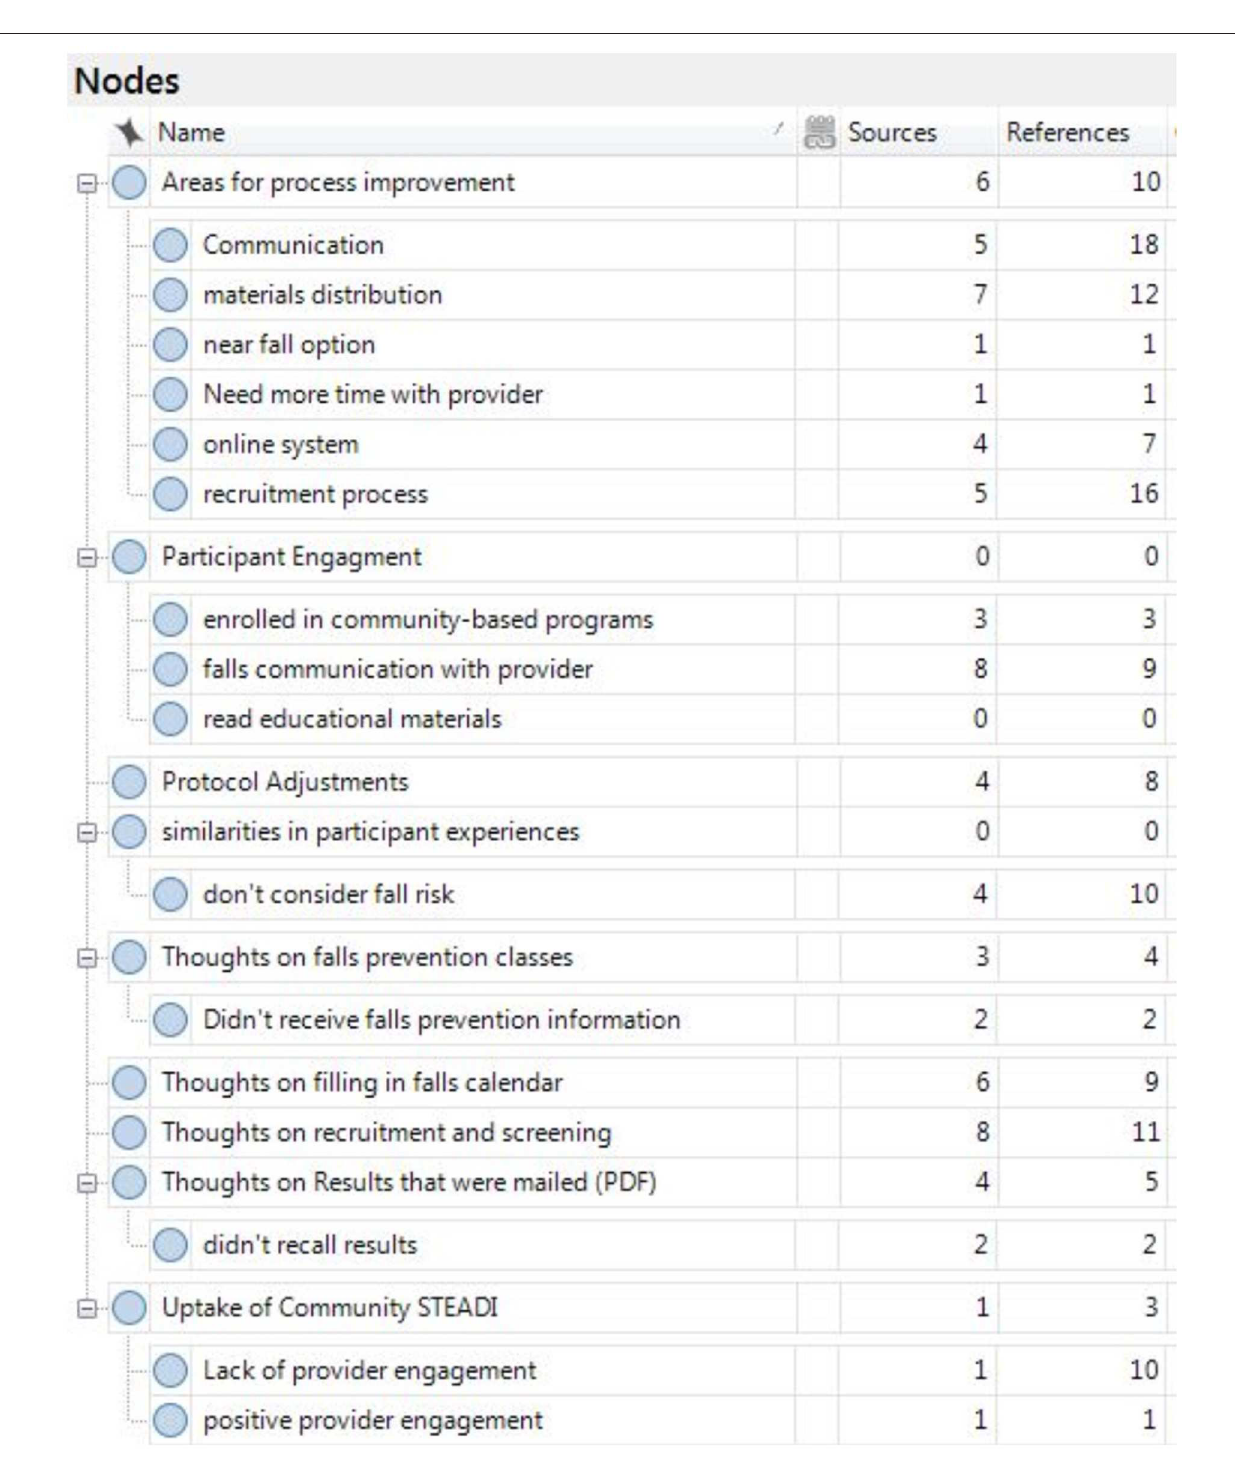
Screenings should not take place while participants are waiting to see their providers. (2) Falls calendar emails should clearly come from the health provider, display a large screen